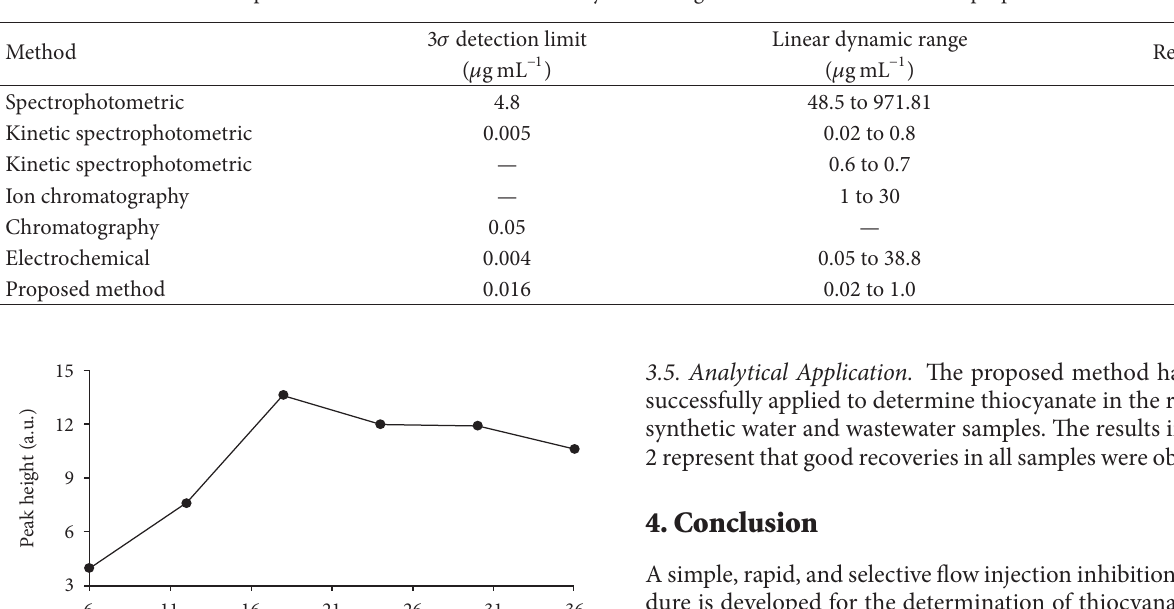
T 3: A comparison of detection limit and linear dynamic range of several methods with the proposed